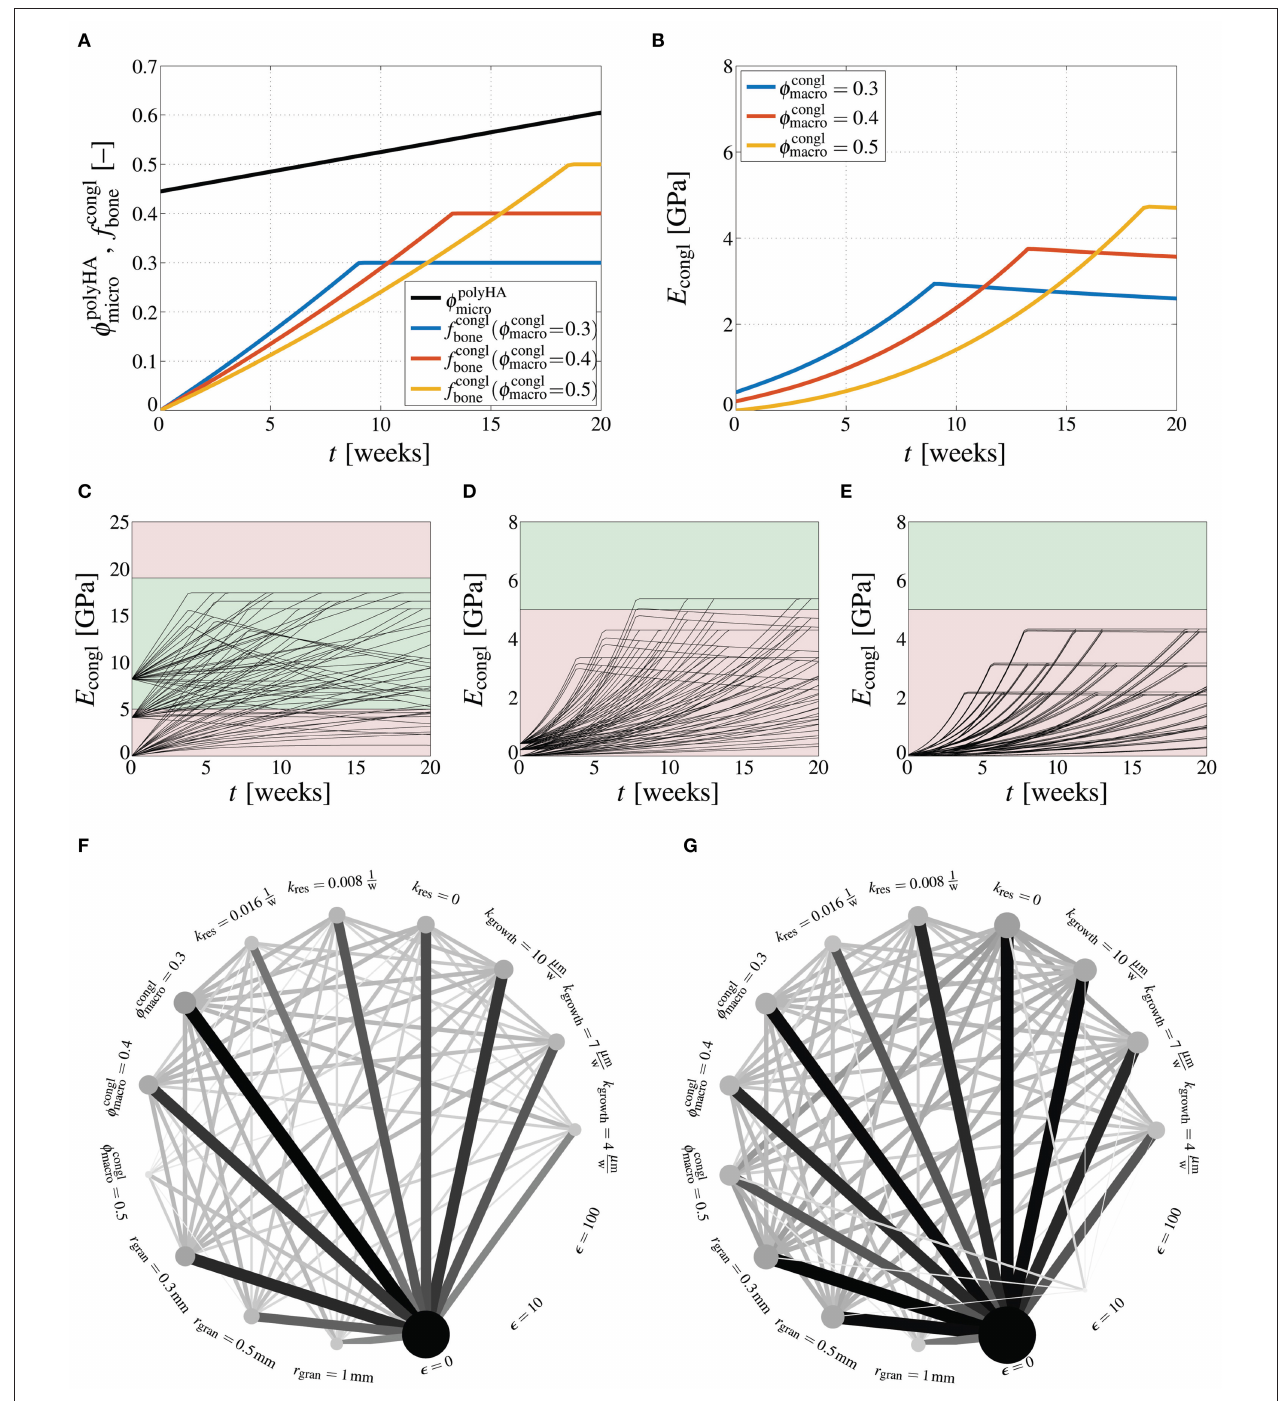
FIGURE 6 | How design parameter combinations affect bone regeneration. Evaluation of bone regeneration kinetics laws, Equations(59) and (60), for r gran 500 µ m, ǫ 10, k growth 7 µ m/week, and k res 0.008week − 1 , in terms of microporosity and bone tissues volume fraction evolutions (A) , and in terms of = = = = the respective Young’s modulus (B) ; model-predicted development of the Young’s modulus of the macroscopic scaffold material, E congl , in GPa, during bone 0.3 , 0.4 , 0.5 , regeneration, for varying crack density parameter ǫ 0 , 10 , 100 , granule radius r gran 300 µ m , 500 µ m , 1000 µ m , macroporosity φ congl macro = { } = { } = { } resorption rate k res 0 , 0.008week − 1 , 0.016week − 1 , and bone ingrowth rate k growth 4 µ m/week , 7 µ m/week , 10 µ m/week , depicted for (C) ǫ 0, (D) = { } = { } = ǫ 10, and (E) ǫ 100, with the green area ranging from 5 to 19GPa indicating the targeted stiffness range; graphical representation of successful parameter = = combinations at (F) t 5weeks, and (G) t 20weeks, with circle sizes being proportional to the success of specific parameter combinations and line thicknesses = = being proportional to the success of specific parameter combinations.